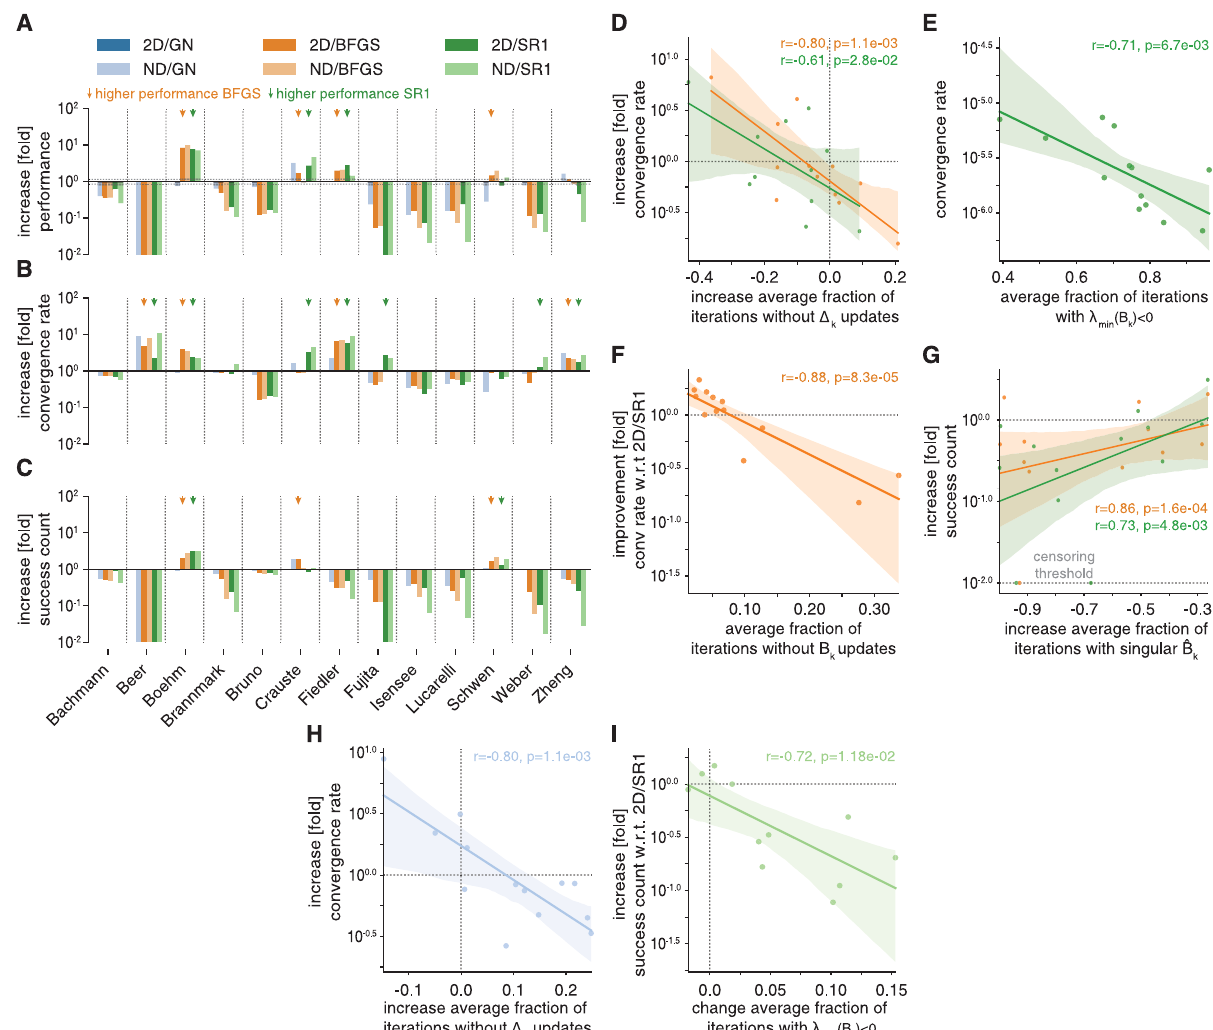
Fig 4. Evaluation of iterative Hessian approximation schemes. Color scheme is the same in all panels. All increases/decreases are relative to fides 2D/GN unless otherwise noted. A : Performance comparison ( ϕ ). B : Increase in convergence count γ . C : Increase in convergence rate ν . D : Association between increase in average fraction of iterations without updates to the trust-region radius Δ and increase in ν for fides 2D/SR1 (green) and k is fides 2D/BFGS (orange). E : Association between average fraction of iterations where smallest eigenvalue λ min of the transformed Hessian ^ B ð SR 1 Þ k negative and ν for fides 2D/SR1 . F : Association between fraction of iterations without updates to B k and increase in ν relative to fides 2D/SR1 for fides 2D/BFGS . G : Association between fraction of iterations with a numerically singular transformed Hessian ^ B and increase in γ for fides k 2D/SR1 (green) and fides 2D/BFGS (orange). Change in γ was was censored at a threshold of 10 − 2 to visualize models with γ . H : Association between fraction of iterations without updates to Δ k and increase in ν for fides ND/GN . I : Association between change in average fraction of is negative and γ relative to fides 2D/SR1 for fides ND/SR1 . iterations where smallest eigenvalue λ min of the transformed Hessian ^ B ð SR 1 Þ k